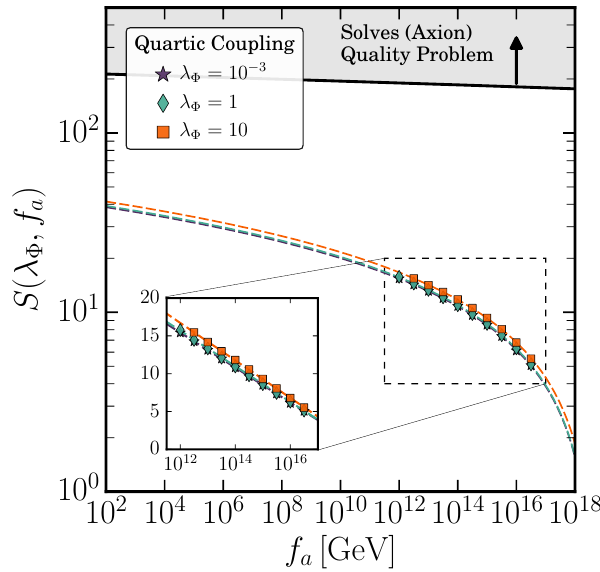
Figure 1 . U(1) wormhole action within General Relativity. We find the expected scaling S ∼ log M pl /f a . Also shown is the value of the action required to solve the axion quality problem. Furthermore, we see that the action is broadly insensitive to the quartic coupling λ Φ